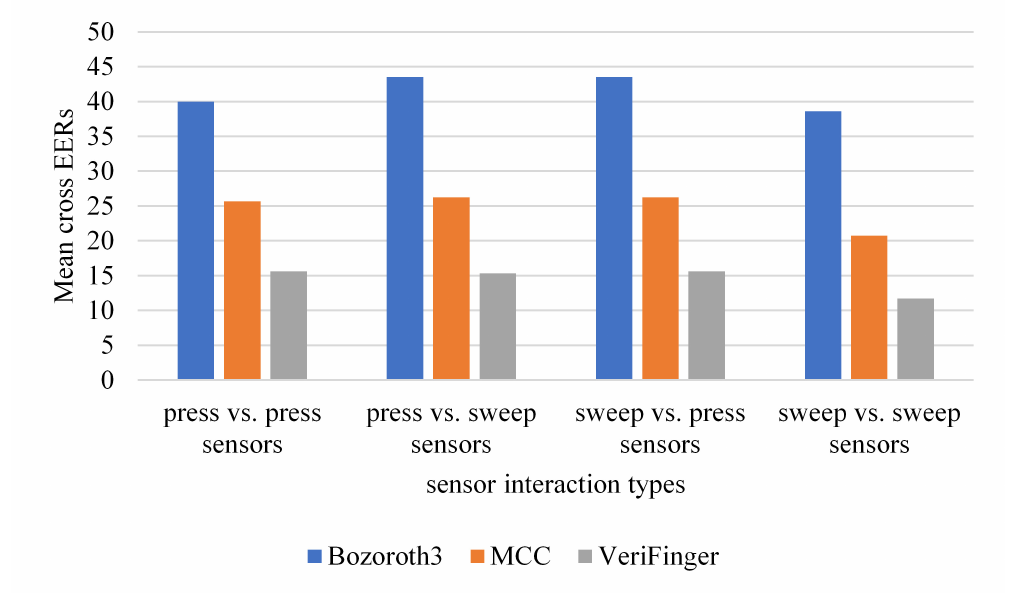
Figure 10. Mean cross EERs of the three methods for each sensor interaction